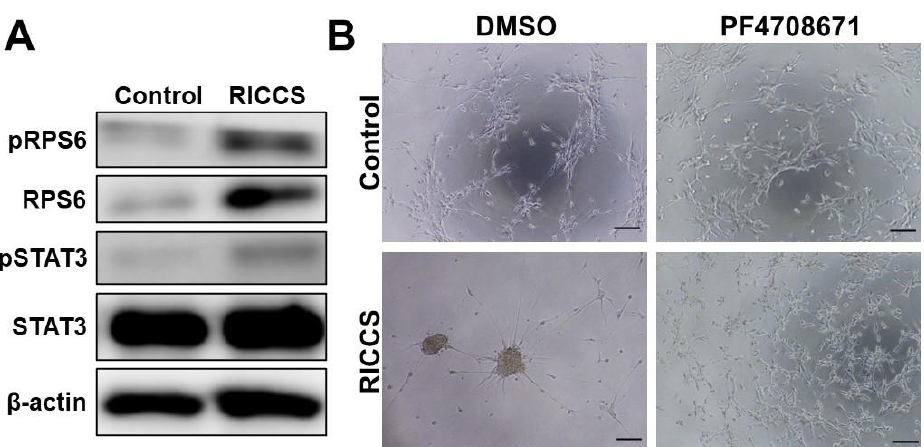
Figure 2. Involvement of intrinsic ribosomal protein S6 in RICCS formation. ( A ), Western blot showing that RPS6 phosphorylation, RPS6 expression, and STAT3 phosphorylation were induced in RICCS. ( B ), PF4708671 (RPS6 kinase inhibitor) treatment completely suppressed the sphere-forming ability in RICCS. Scale bar: 200 µm.